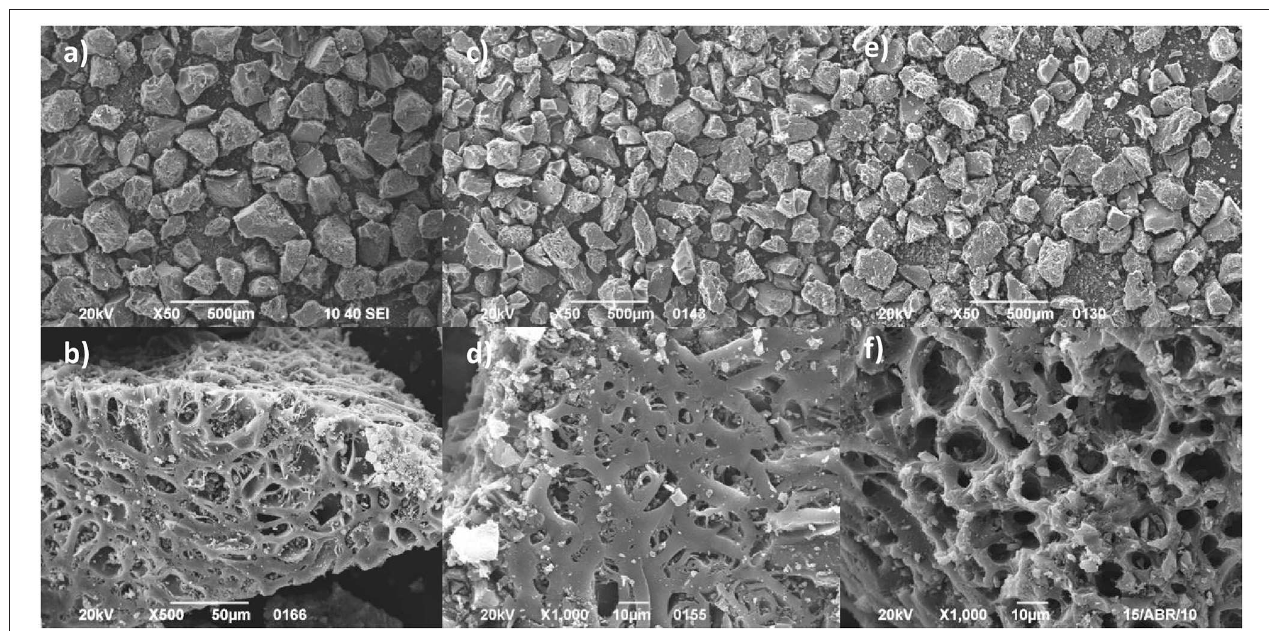
FIGURE 2 | SEM images of (a,b) parent activated carbon, AC; (c,d) thermal treated activated carbon, AC-T, and (e,f) gasified activated carbon, AC-G.